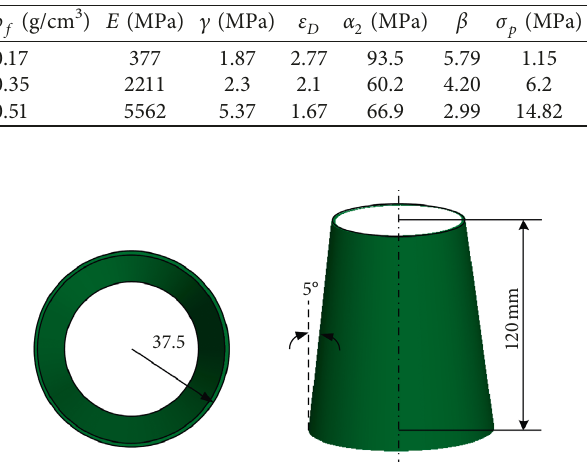
Table 1: Material parameters of aluminum foam with different densities [27, 28].